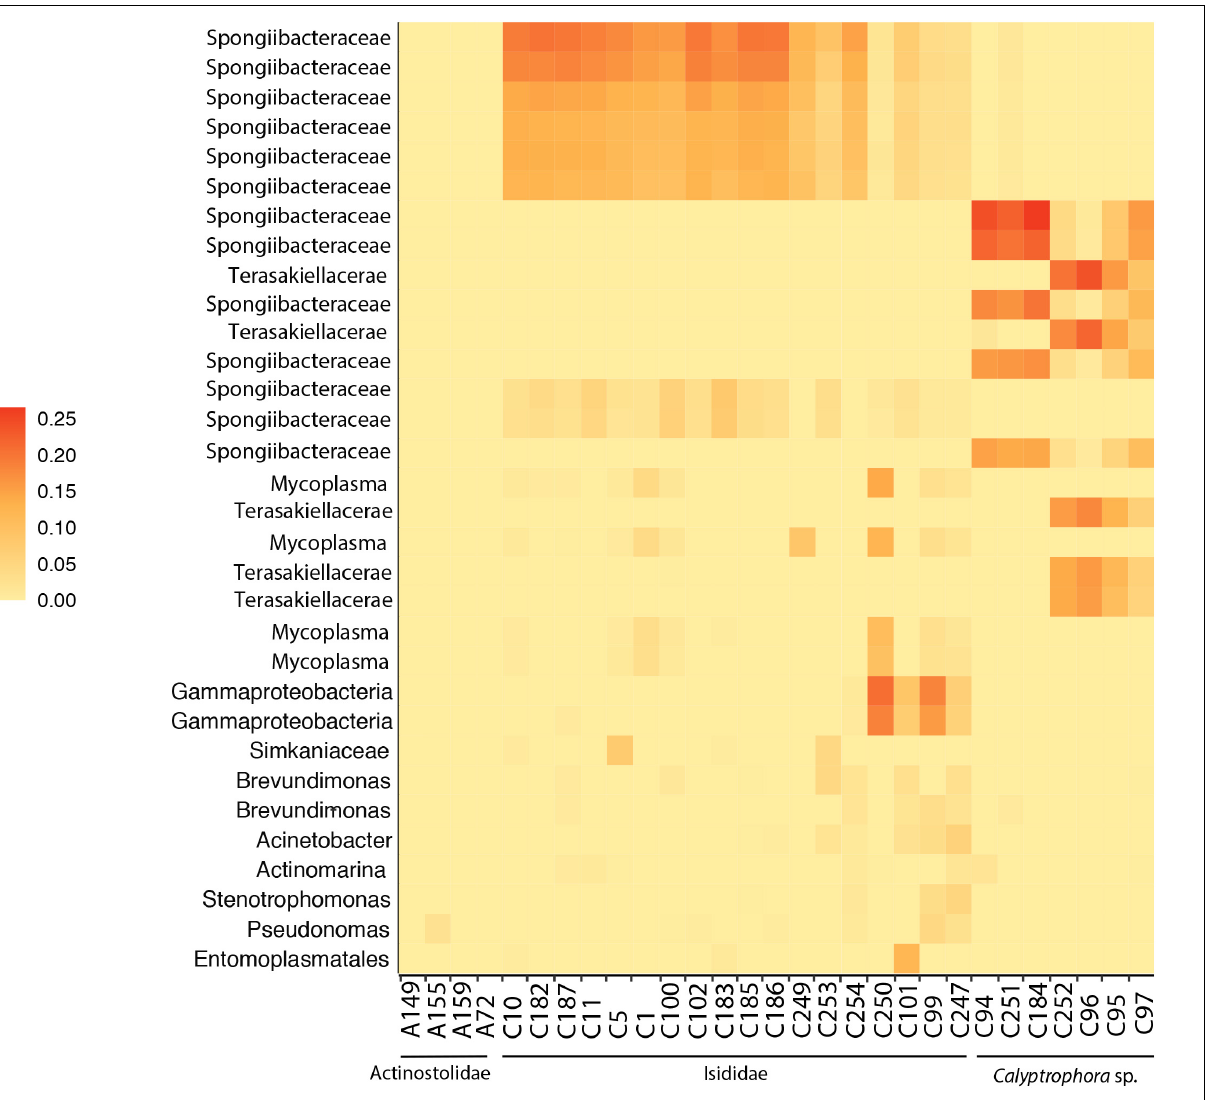
FIGURE 3 | Heatmap of the relative abundances of ASVs taxa accounting for the cumulative 80% of total abundance in anemones (A) and coral (C)